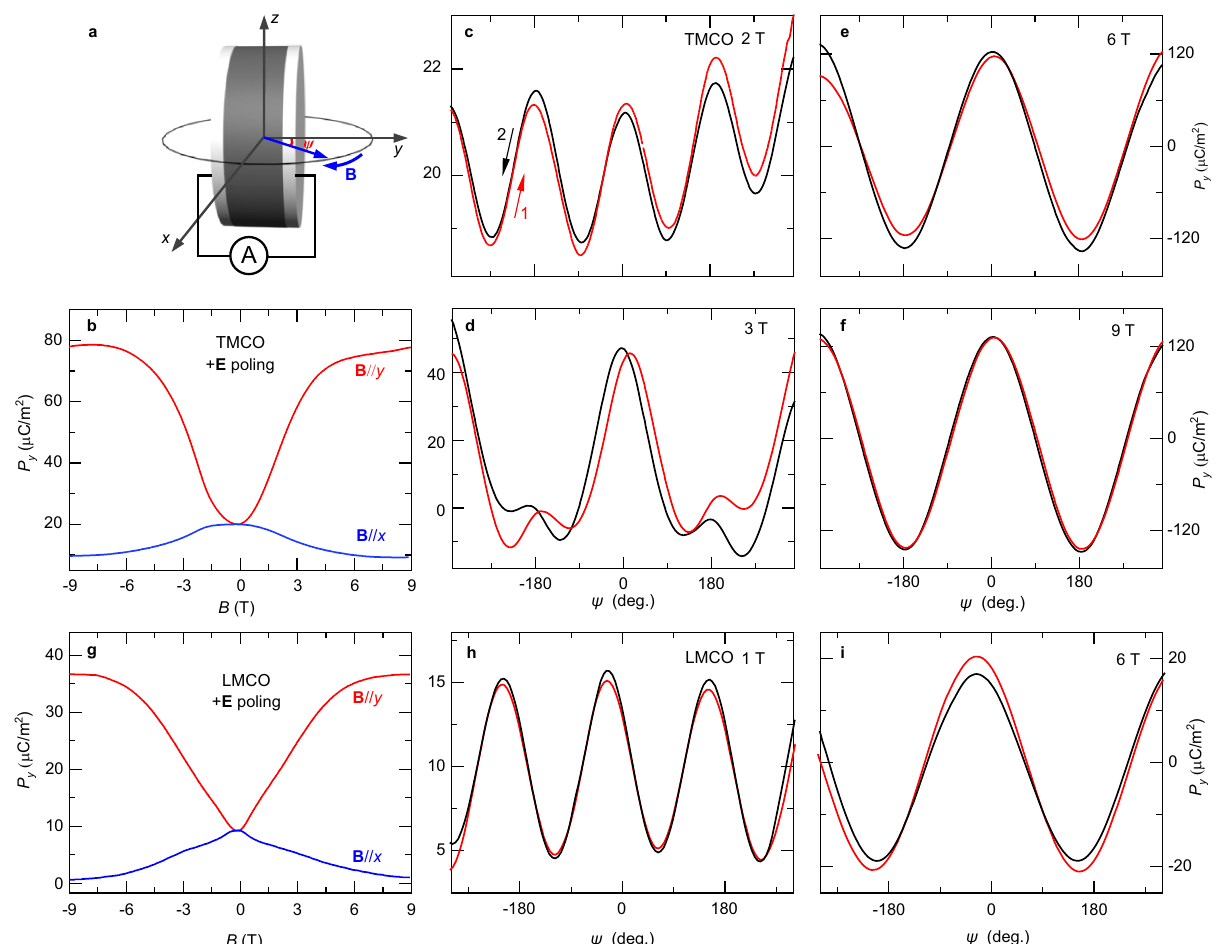
Fig. 5 Polarization variations under sweeping and rotating B at 10 K for TMCO and LMCO. a Schematic illustration of measurements for magnetoelectric current under rotating B within the xy- plane; ψ denotes the angle between B and the y -direction. b , g Magnetic- fi eld-dependent P y at T = 10 K after + E poling for B // E and B ⊥ E con fi gurations of TMCO and LMCO, respectively. P y is de fi ned as the component of P along the y -axis. c – f ψ - dependent polarization of TMCO at B = 2 T c , 3 T d , 6 T e , and 9 T f . The red and black arrows indicate an increase or decrease in angle, respectively. h , i ψ - dependent polarization of LMCO at B = 1 T h and 6 T i . All polarizations were integrated from the ME current as a function of B // x con fi guration (Fig. 5a). In both con fi gurations, quadratic ME